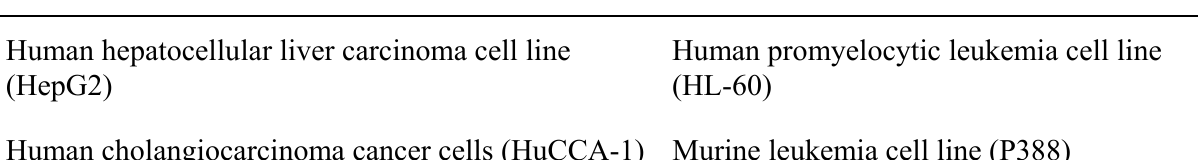
Table 6. Twelve cell lines used for the cytotoxicity assays. Cell